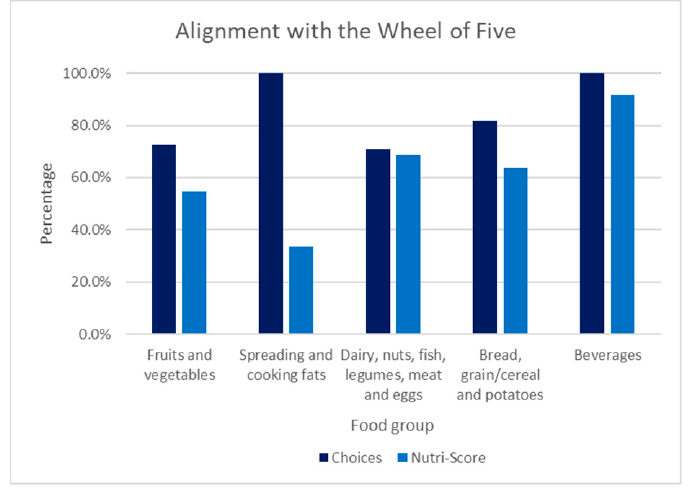
Figure 7. Extent of alignment of the NPSs (Choices and Nutri-Score) with the Wheel of Five (as percentages of correct assessments) for each food group of the Wheel of Five. A correct assessment is a score of 1 or 2 for a product compliant with the Wheel of Five or a score of 3, 4, or 5 for a product that is not compliant with the Wheel of